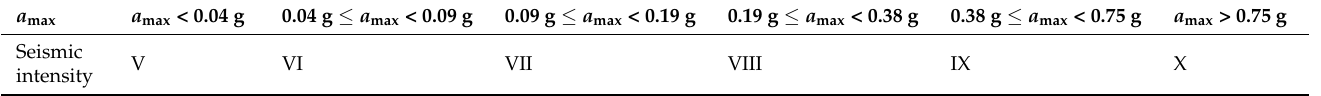
Table 2. Peak acceleration zones of ground